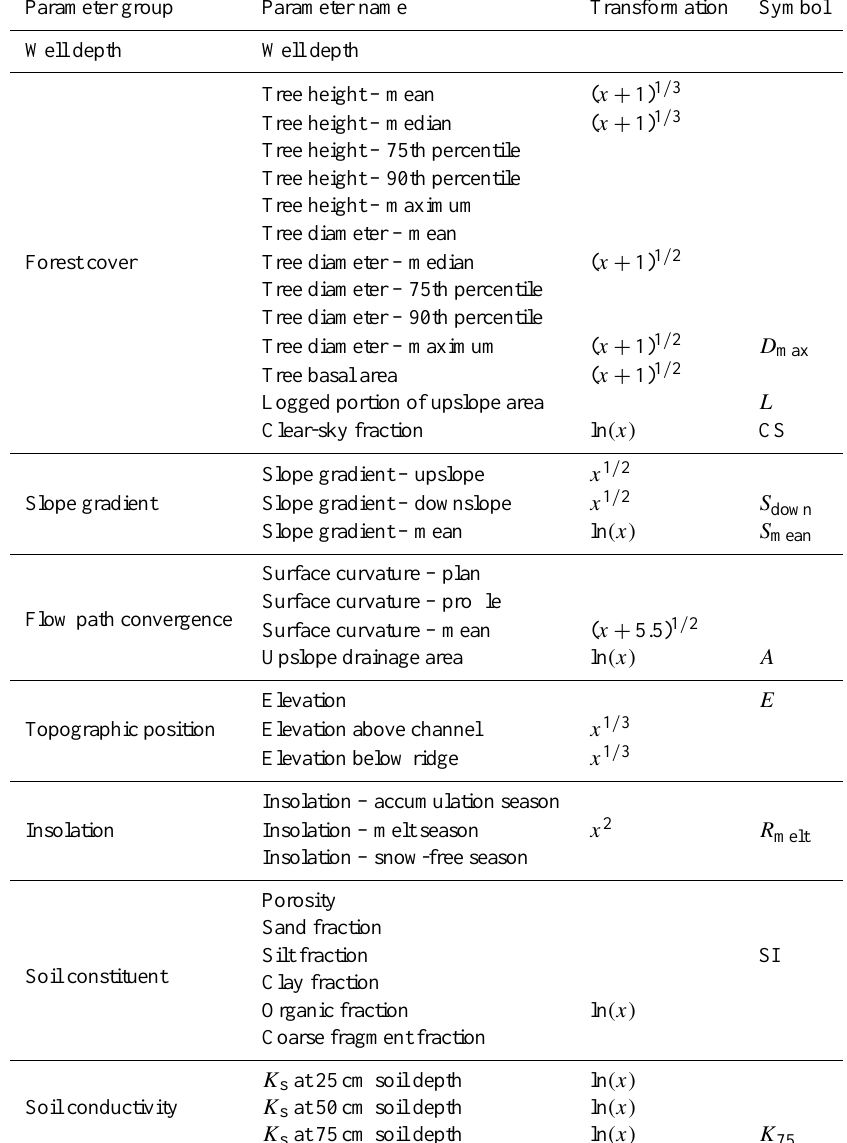
Table 2. Physiographic parameters and corresponding transformations applied for the logistic regression analyses. Parameter symbols are defined only for parameters retained in the final models (Table